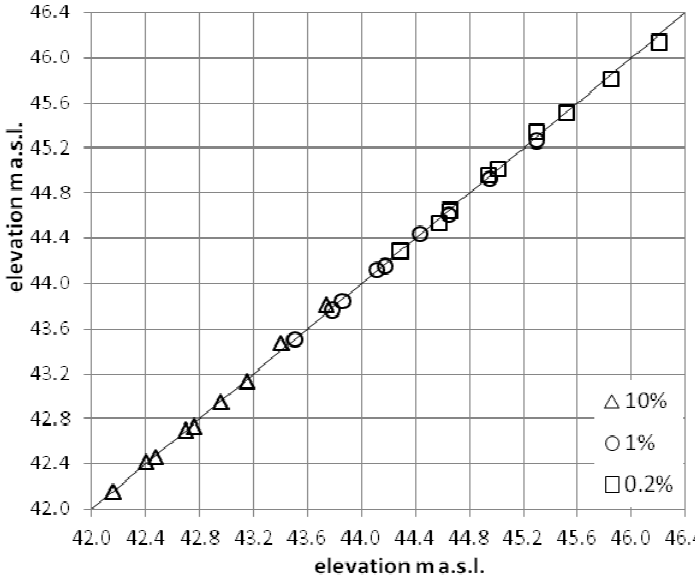
Figure 7. Quality of the model